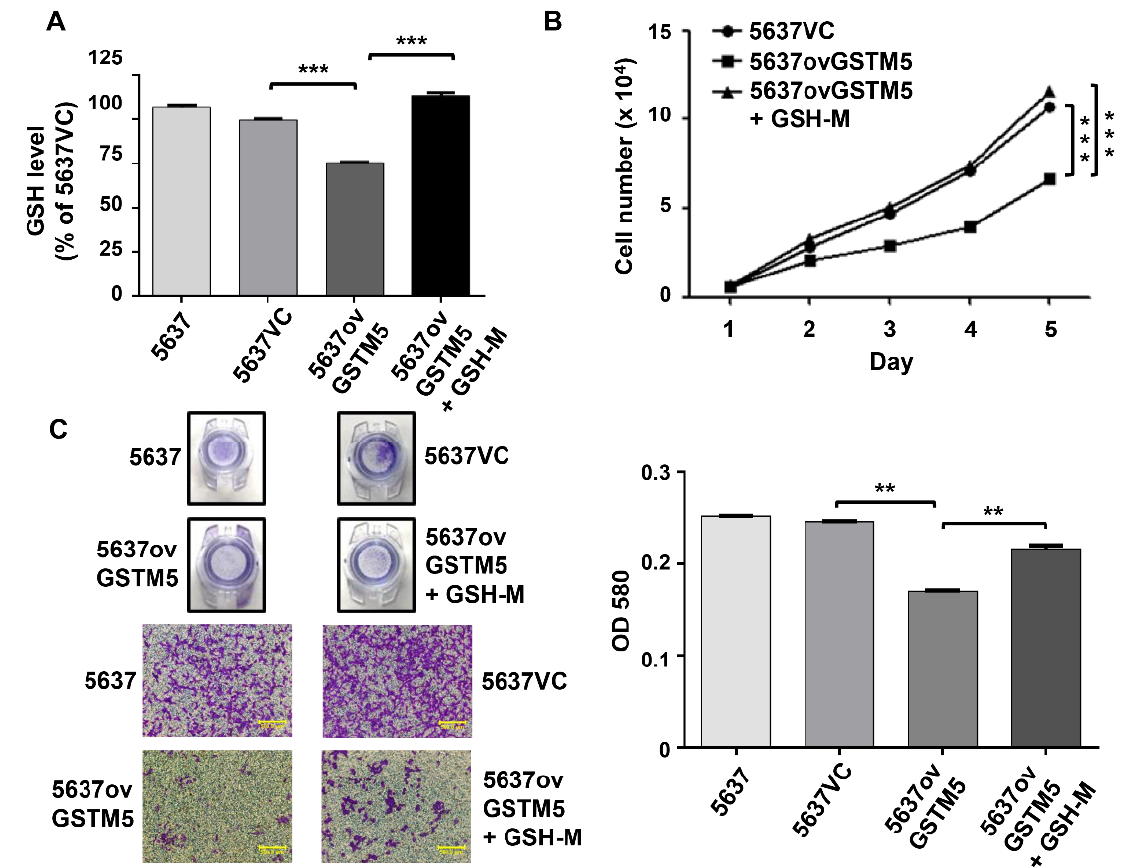
Figure 5. GSH supplementation restores the cell proliferation and migration ability of bladder cancer cells, overexpressing GSTM5. Four millimolar GSH-M-treated 5637ovGSTM5 cells showed an increase in ( A ) intracellular GSH levels, ( B ) cell proliferation and ( C ) cell migration. Upper panel: Transwell insert with a circular membrane of 0.65 cm diameter. Lower panel: microscopic images; scale bar is 500 µm. All data are presented as the mean ± SE of three independent experiments. ** p < 0.01; *** p < 0.001.